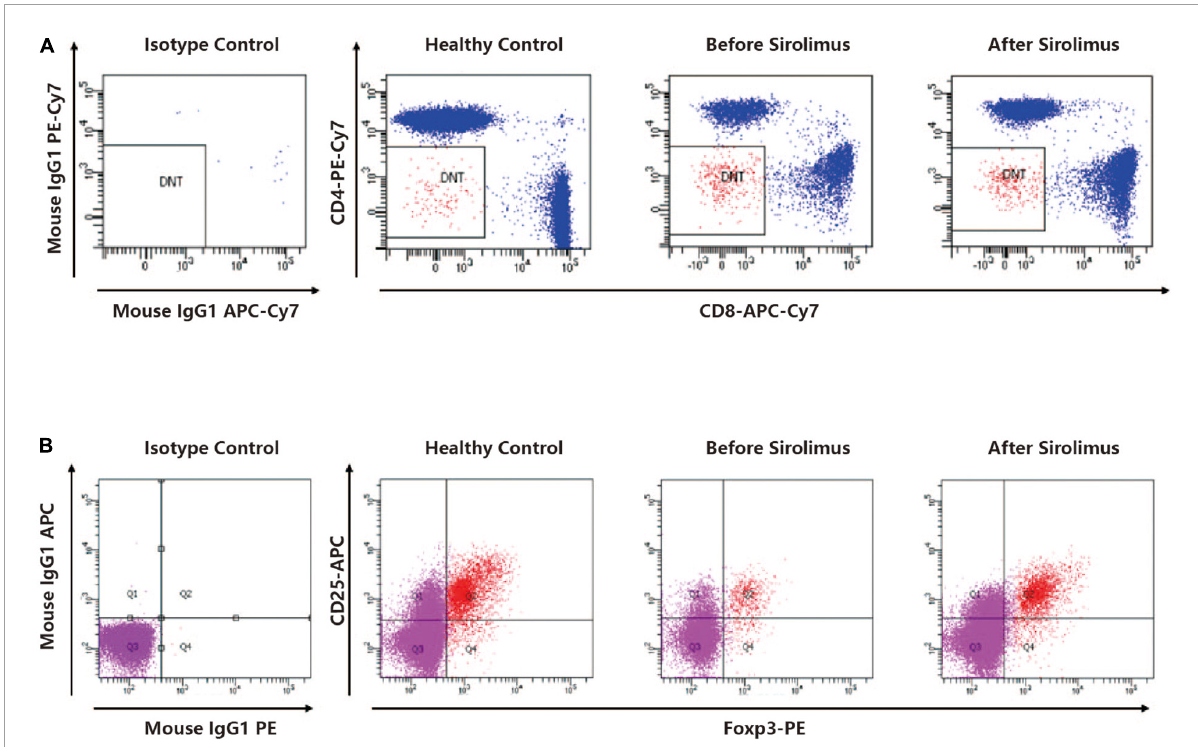
FIGURE2 (A) A representative dot plot analysis of CD4-CD8-TCR αβ + cells gated in the CD3 + cell fraction showed elevated DNT ratio compared to a healthy control. The DNT ratio of the patient decreased after sirolimus treatment. (B) A representative dot polt analysis of CD25 + foxP3 +